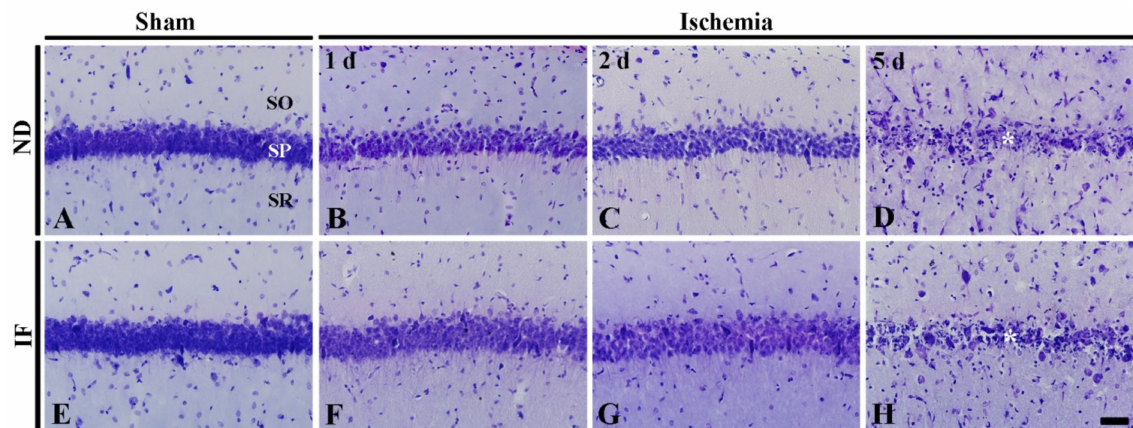
Figure 4. Cresyl violet (CV) staining in the CA1 region of the ND (upper column) and IF (lower column) groups at sham ( A , E ), 1 day ( B , F ), 2 days ( C , G ) and 5 days ( D , H ) after ischemia. Numerous CV-positive cells are found in stratum pyramidale (SP). CV stainability of cells in the SP is gradually decreased after ischemia in both of the ND/ischemia and IF/ischemia groups, and, at 5 days after ischemia, CV-positive cells in the SP of the groups are damaged (asterisks). Scale bar = 50 µ m. IF, intermittent fasting; ND, normal diet; SO, stratum oriens; SR, stratum